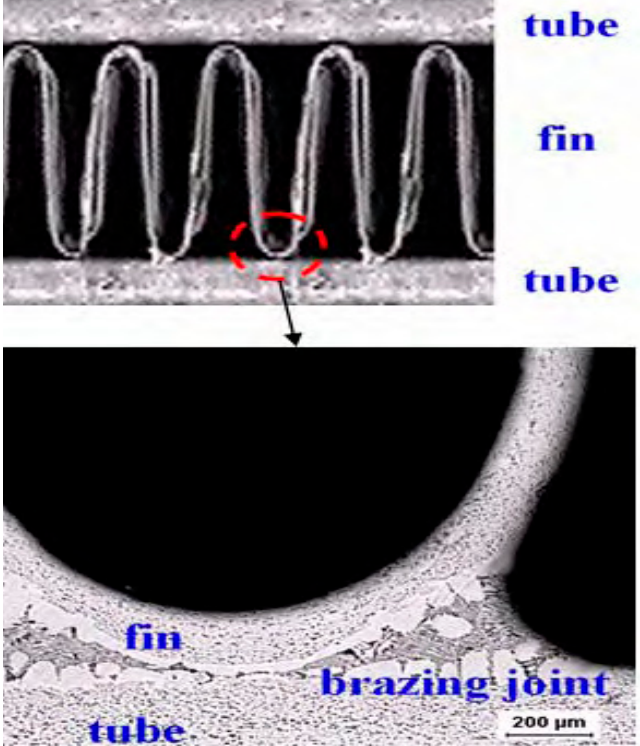
Figure 1. Cross-sectional view of the Al fin-tube heat exchanger assembled by the brazing